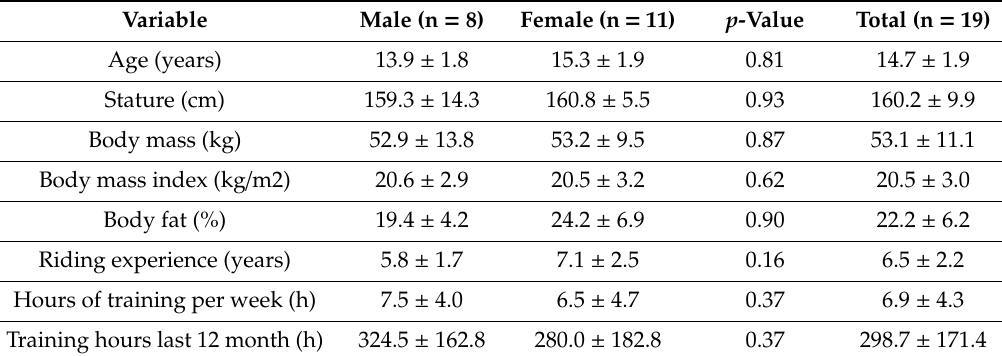
Table 1. Demographic and sport data for equestrian athletes of the Murcia Regional